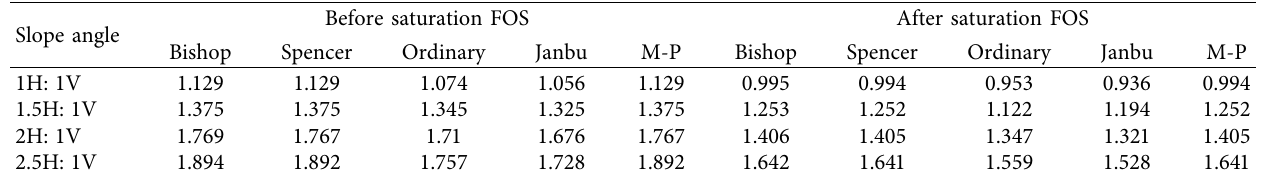
Table 8: FOS values for slope-1 for different slope angles before and after saturation.